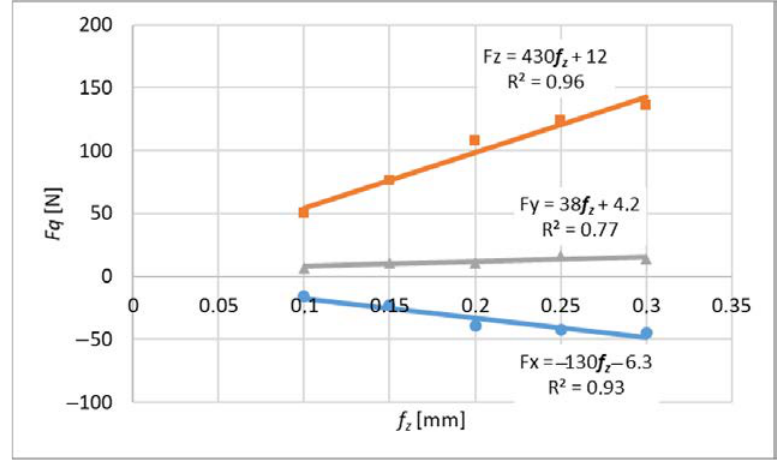
Figure 10. Graph of the average cutting forces for plunge milling.